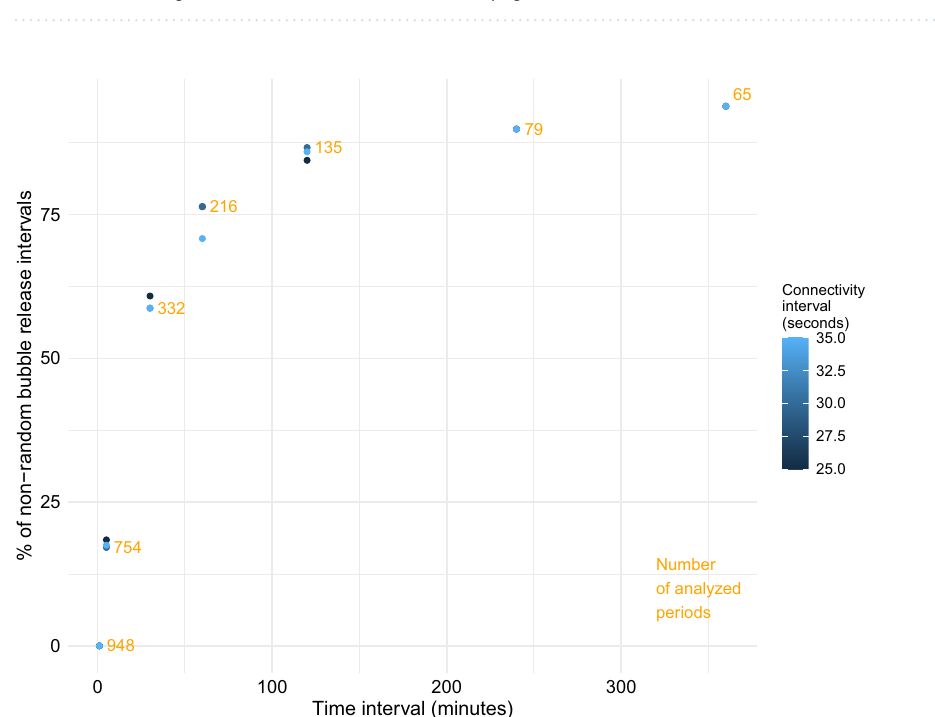
Figure 3. The percentage of the time intervals where the observed connectivity of the release events was determined to be non-random. Yellow numbers represent the number of analyzed time intervals with 2 or more release events for each interval length. The connectivity interval is the period within following gas releases were considered to be